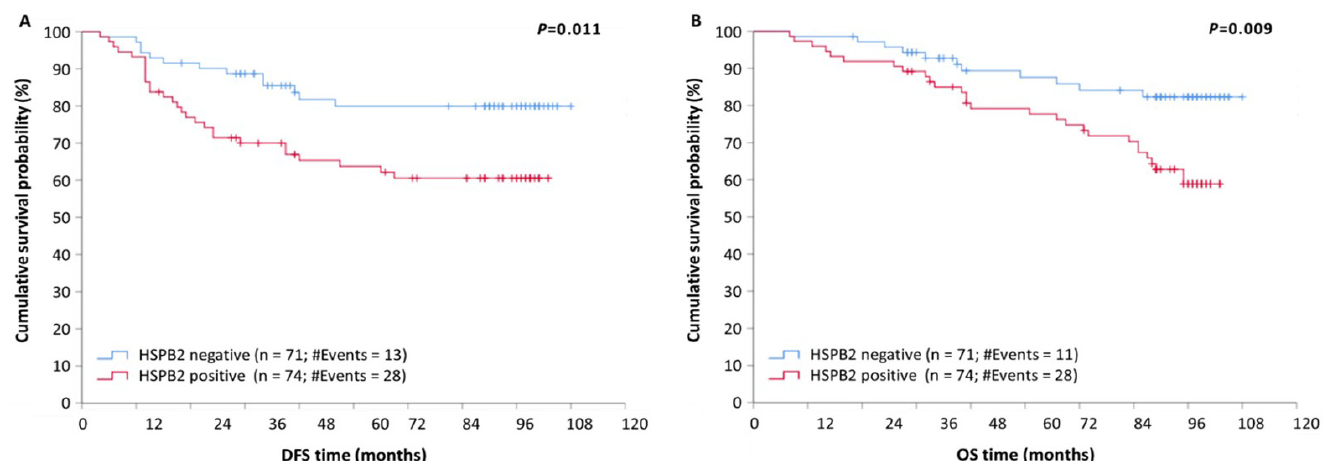
Figure 3. Kaplan–Meier survival curves for disease-free survival (DFS) and overall survival (OS) of BrCa patients. ( A ) Patients with tumors being positive for HSPB2 mRNA expression had shorter DFS time intervals than patients with HSPB2 -negative tumors ( p = 0.011). ( B ) Patients with HSPB2 -positive tumors had shorter OS than those with HSPB2 -negative tumors ( p < 0.009). p -value was calculated using the log-rank test. Table 3. HSPB2 mRNA expression status and disease-free survival (DFS) of BrCa patients. Univariate Analysis ( n = 145) Multivariable Analysis 1 ( n = 145)